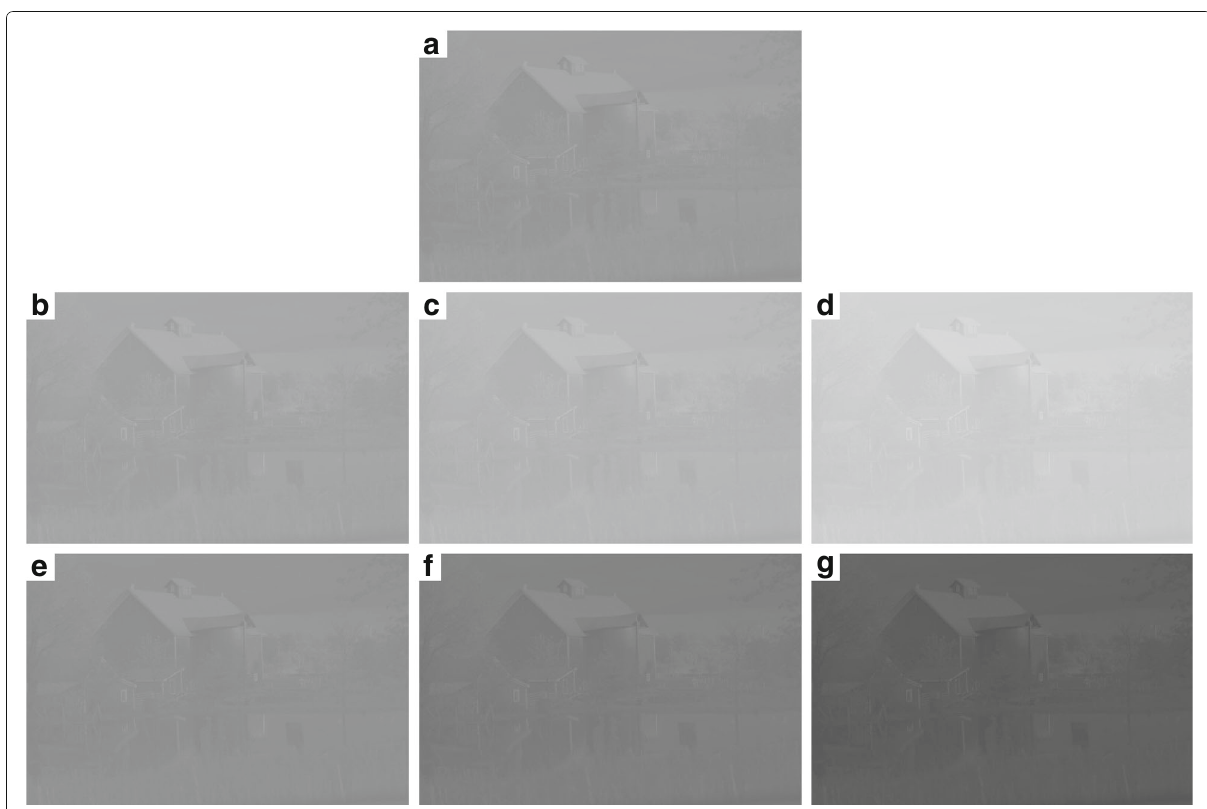
Fig. 4 Intensity shifts of histogram bins in dataset 2. Contrast distorted image with 90% compression ( a ), 10 bins to right ( b ), 30 bins to right ( c ), 60 bins to right ( d ), 10 bins to left ( e ), 30 bins to left ( f ), 60 bins to left ( g